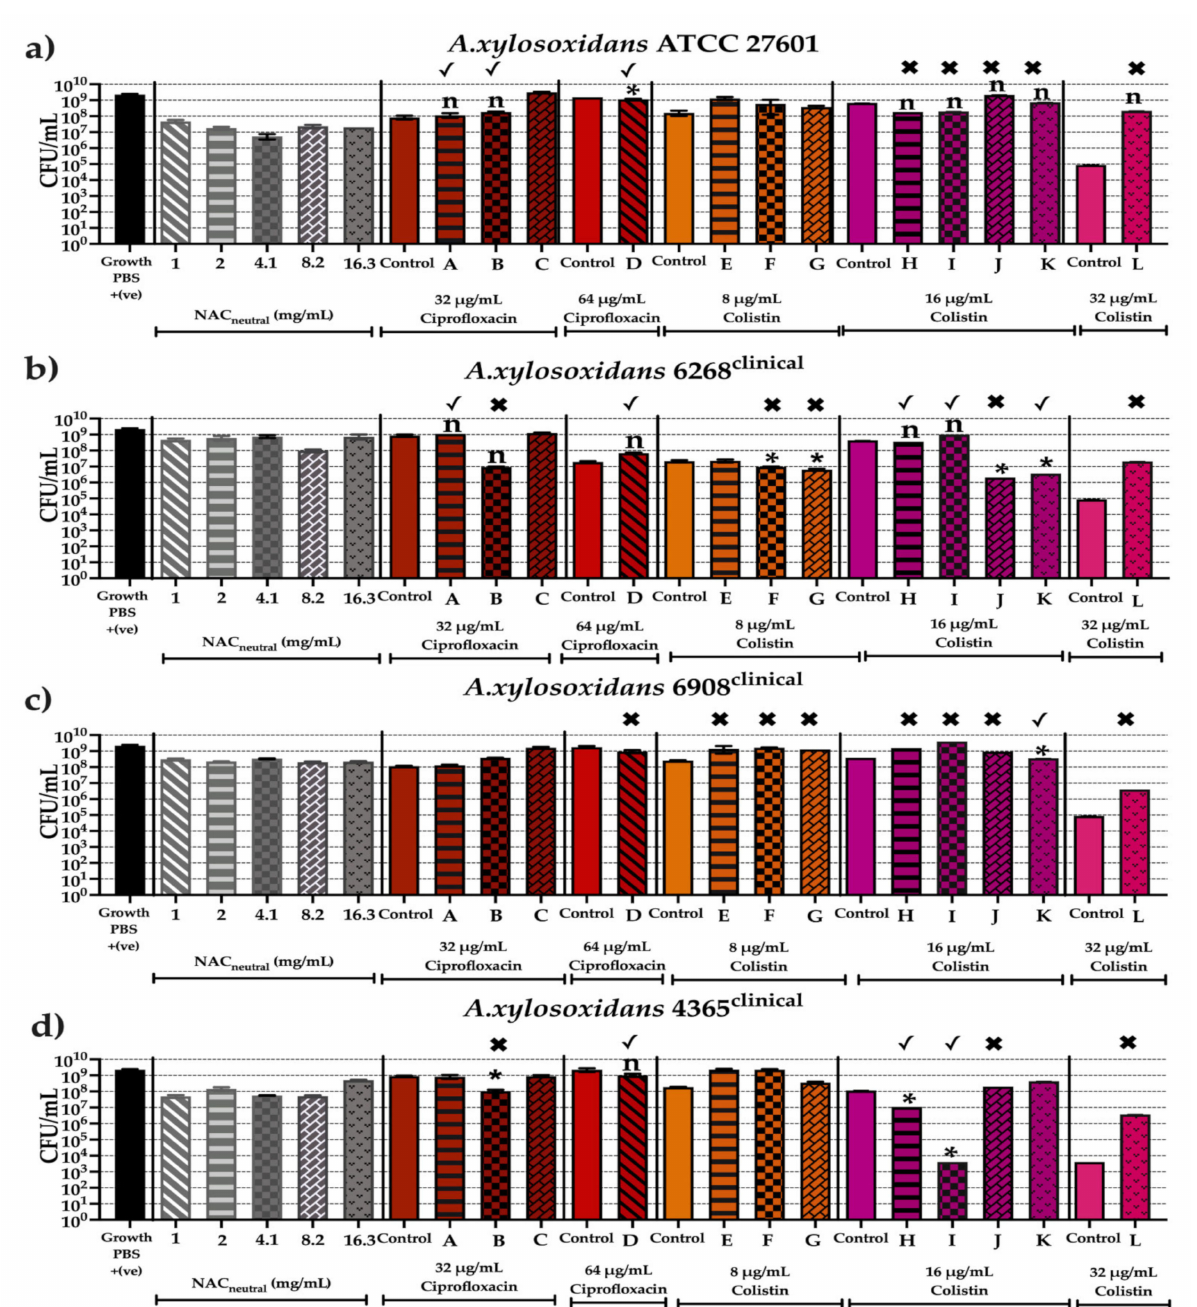
Figure 7. Anti-biofilm activity of screened combinations after 24 h against bacterial strains of A. xylosoxidans strains after 24 h using colony forming units (CFU/mL). In vitro effectiveness of combination therapies (CT) (Table 3) after 24 h on the following A. xylosoxidans strains ( a ) ATCC 27601, ( b ) AX 4365, ( c ) AX 6268, ( d ) AX 6908. ( (cid:51) ) represents combination tested does correspond to planktonic result in FICI analysis. ( (cid:54) ) represents combination tested does not correspond to planktonic result in FICI analysis. Statistical analyses were performed using unpaired Student’s t -tests (with Welch’s correction) and multiple comparison tests (Kruskal–Wallis test with Dunn’s correction). Significance cut-offs were p > 0.05 ( n ), p ≤ 0.05 (*). Data represent an average of n = 3 biological